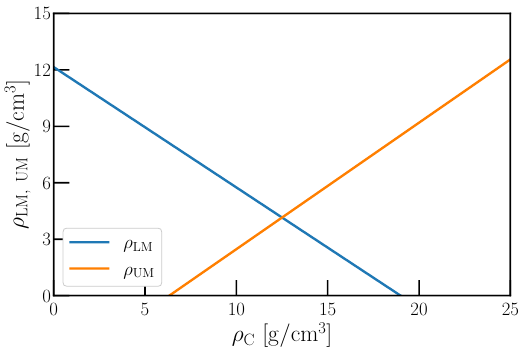
Figure 14 . Constrained relationship between ρ LM (blue) and ρ UM (orange) as a function of the free input parameter ρ , where we assume that the mass of the Earth and its moment of inertia are C known, using the relationships in eqs. (5.3) and (5.4). See text for further